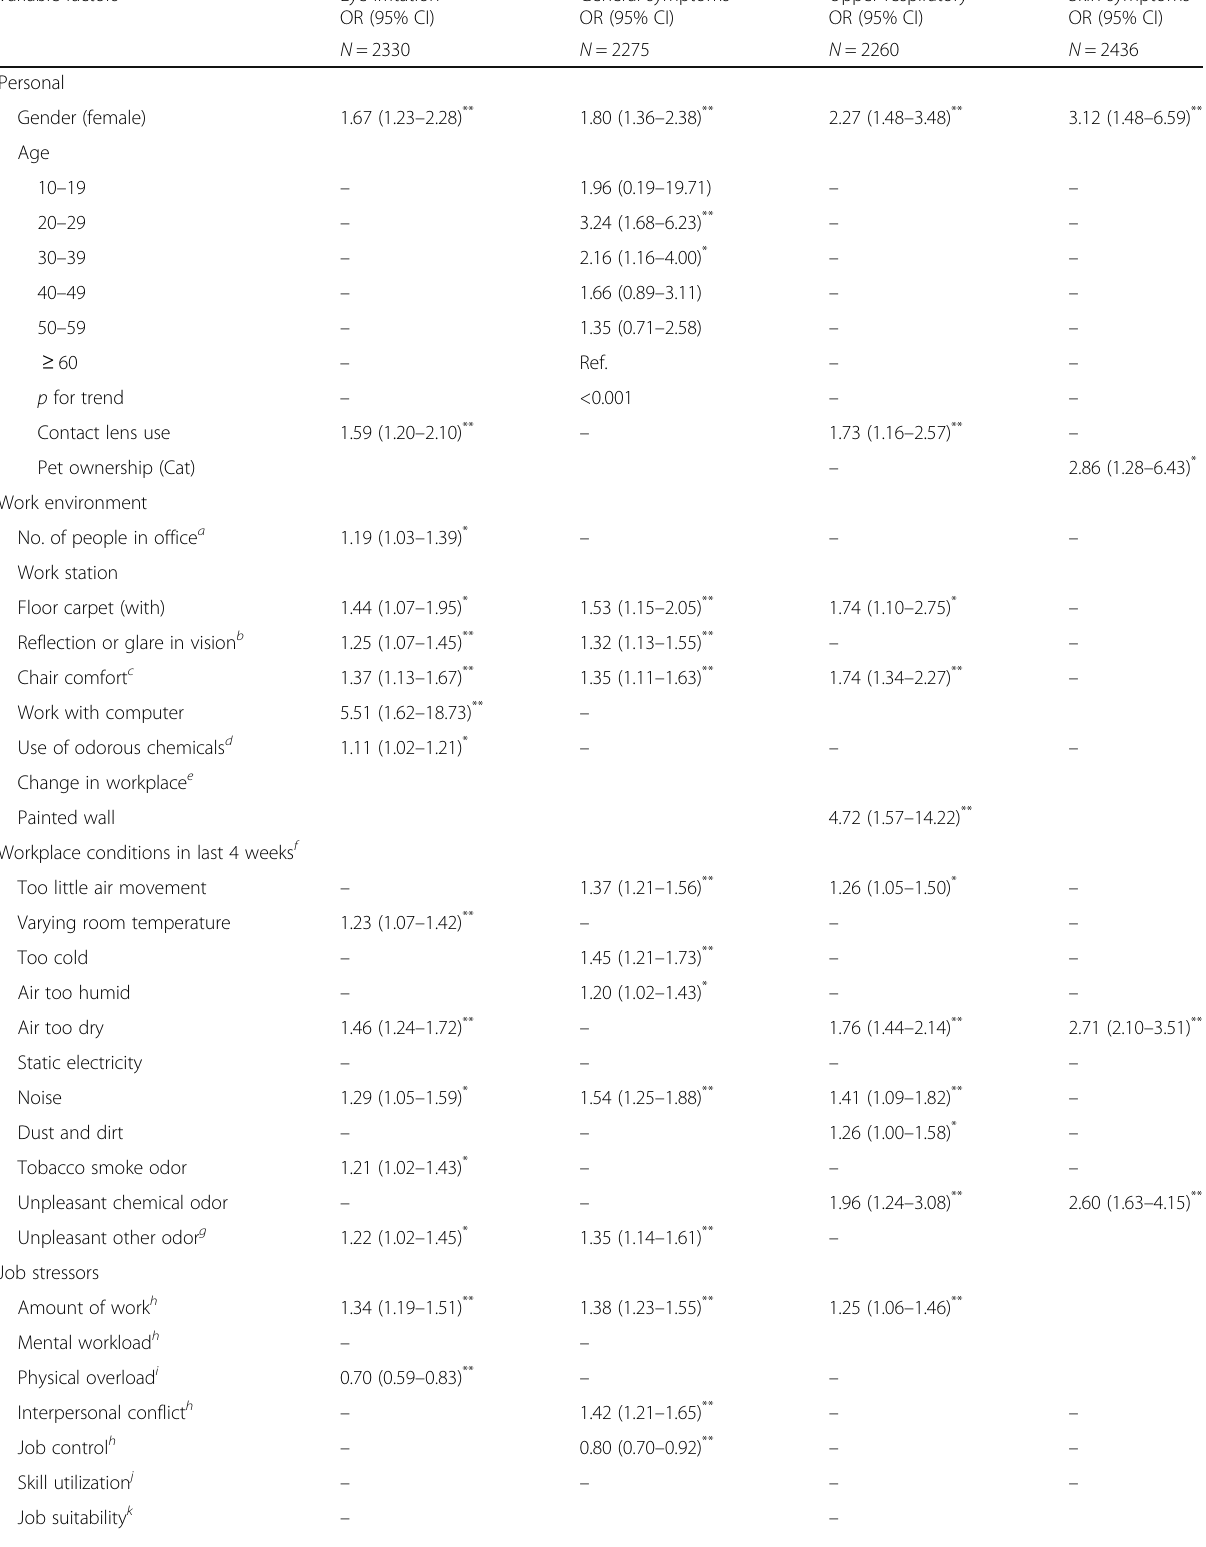
Table 6 Final models for the association between weekly building-related symptoms and all variables (Model